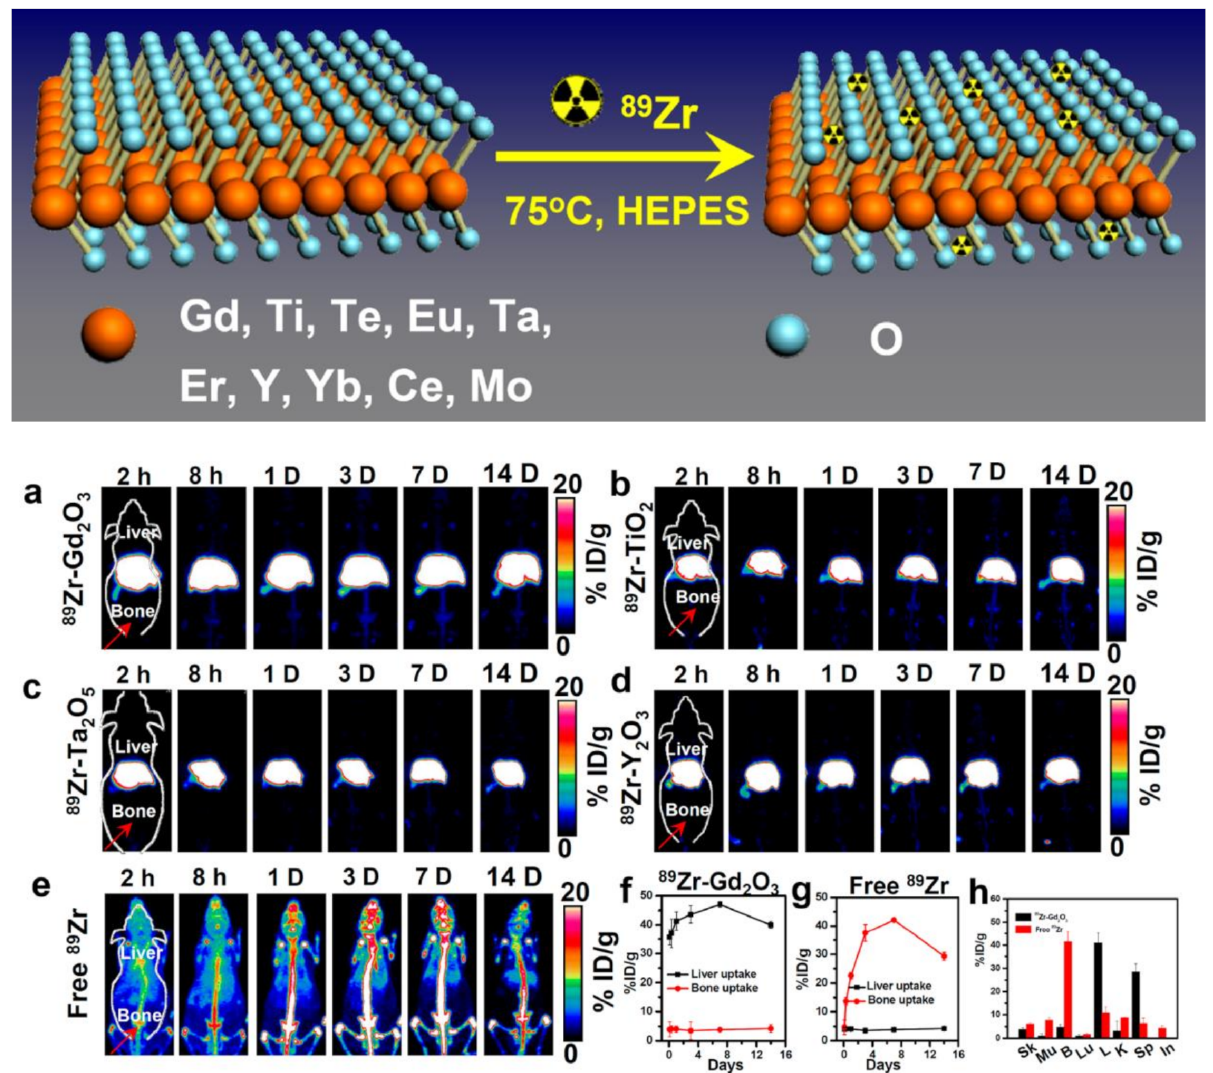
Figure 2. ( top ) Schematic illustration showing the chelator-free labeling of different types of metal oxides (M x O y ) with 89 Zr. ( bottom ) In vivo radiostability study using PET imaging. ( a – e ) In vivo maximum intensity projections (MIPs) of mice after i.v. injection of 89 Zr-M x O y -PEG nanomaterials: ( a ) 89 Zr-Gd 2 O 3 -PEG; ( b ) 89 Zr-TiO 2 -PEG; ( c ) 89 Zr-Ta 2 O 5 -PEG; ( d ) 89 Zr-Y 2 O 3 -PEG), and ( e ) Free 89 Zr at different time points. ( f , g ) Quantitative region of interest (ROI) analysis of the dynamic uptake of 89 Zr after i.v. injection of 89 Zr-Gd 89 Zr ( g ) in bone and liver. ( h ) Biodistribution 2 O 3 -PEG ( f ) or free of 89 Zr-Gd 2 O 3 -PEG and free 89 Zr measured at 14 days p.i. Data are presented as the percentage of injected dose per gram of tissue (%ID/g): Sk, skin; Mu, muscle; B, bone; Lu, lung; L, liver; K, kidney; Sp, spleen; In, intestine. Error bars are based on the standard error of the mean (SEM) of triplicate samples. Reprinted with permission from ref. [30], Copyright 2017 American Chemical